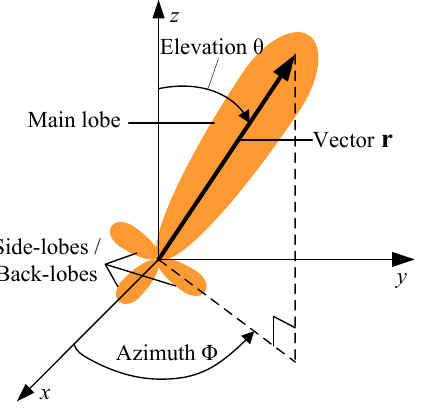
Figure 9. Radiation pattern of a realistic directional